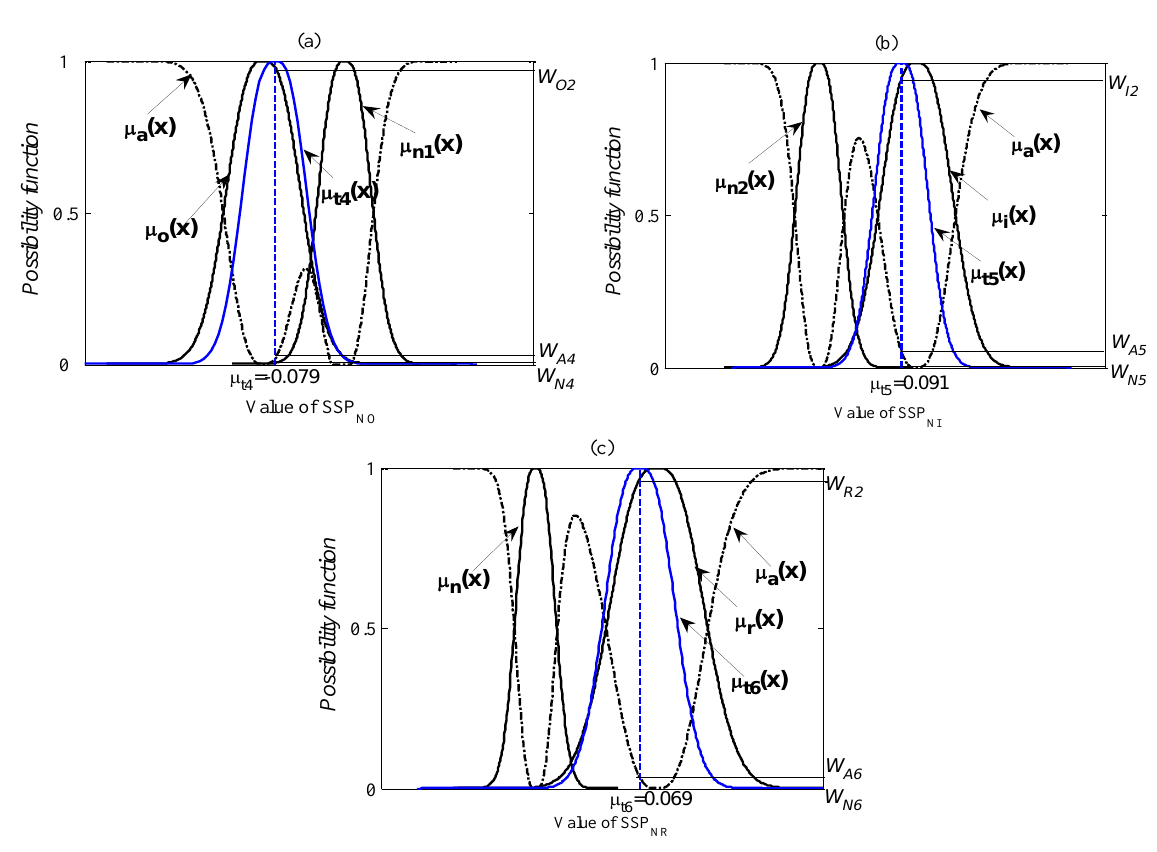
Figure 17. The practical diagnosis examples for the test